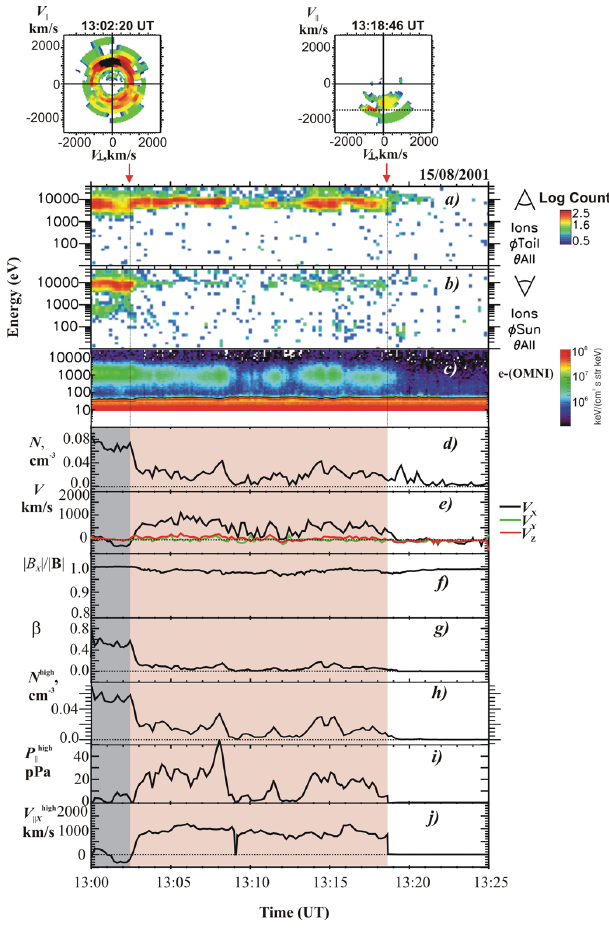
Fig. 1. PS-PSBL-lobe crossing by Cluster s/c on 15 August 2001 be- tween 13:00–13:25UT. Ion data were measured by the HIA instru- ment onboard Cluster-1. Electron data were detected by the PEACE experiment onboard Cluster-2. In the upper part of the Fig. 2d cuts of ion velocity distribution functions plotted in the (V ⊥ ,V || ) plane are shown. Below, from top to bottom: (a, b) Energy-Time ( E - T ) spectrograms of earthward and tailward moving ions corre- spondingly; (c) E - T spectrogram of omni-directional electrons; (d, e) ion density N and three GSE components of velocity calculated for the entire energy range; (f) time profile of the value | B X | / | B | ; (g) plasma β ; (h–j) ion density N high , parallel dynamic pressure P high || and X-component of the parallel velocity V high || calculated X for the high-energy part of the spectrum ( >